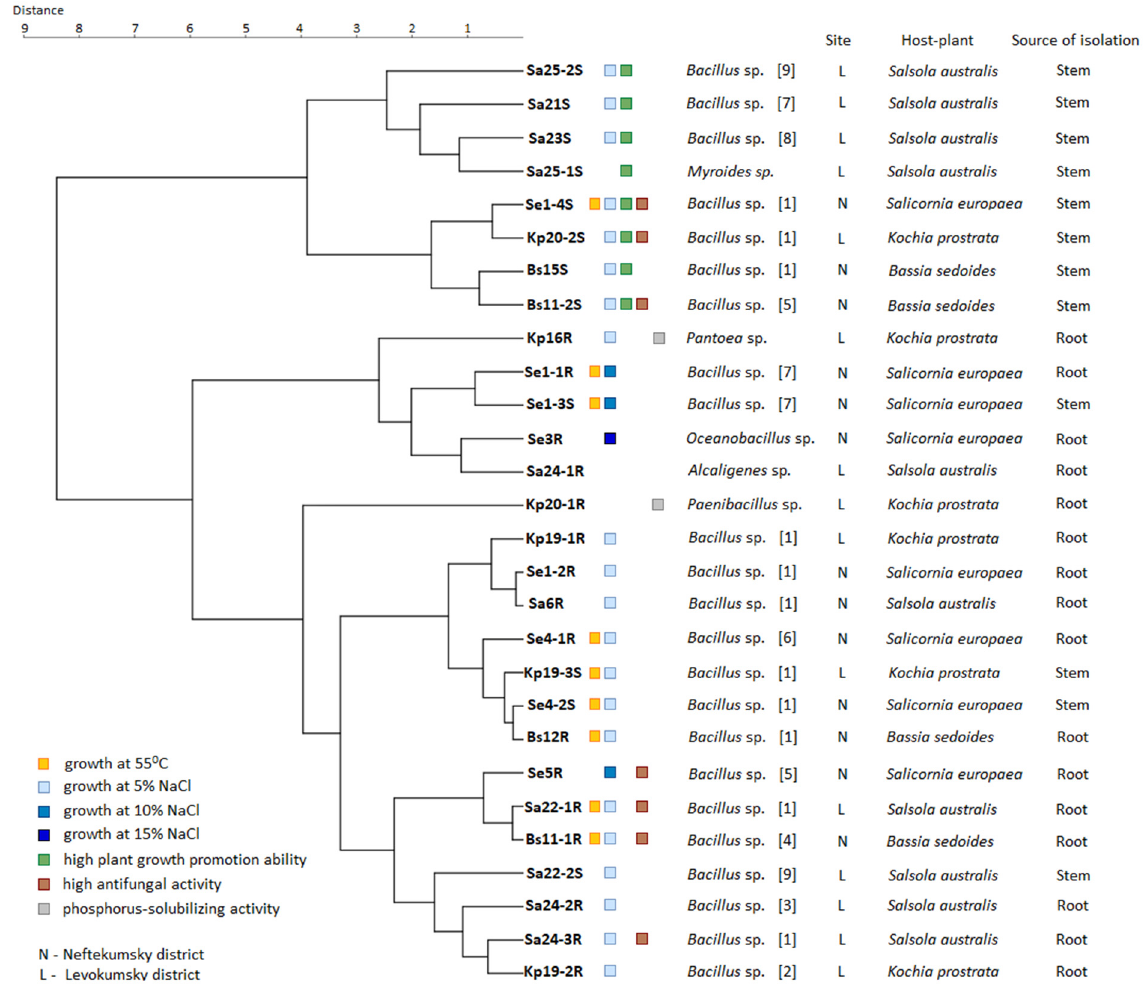
Figure 6. Dendrogram based on phenotypic characteristics of strains showing the relationships between the taxonomy, geographic site, host plant, and source of isolation. The Euclidean distance and Ward clustering methods were used.